Question: How would you classify this visualization?
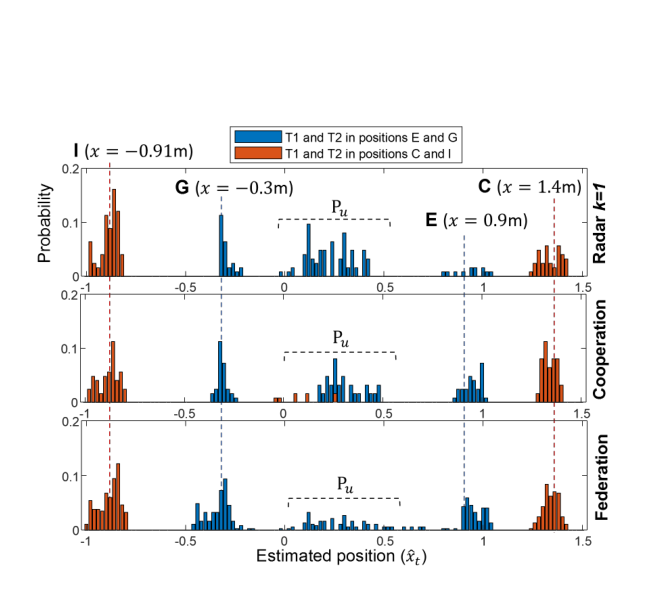
Answer: bar